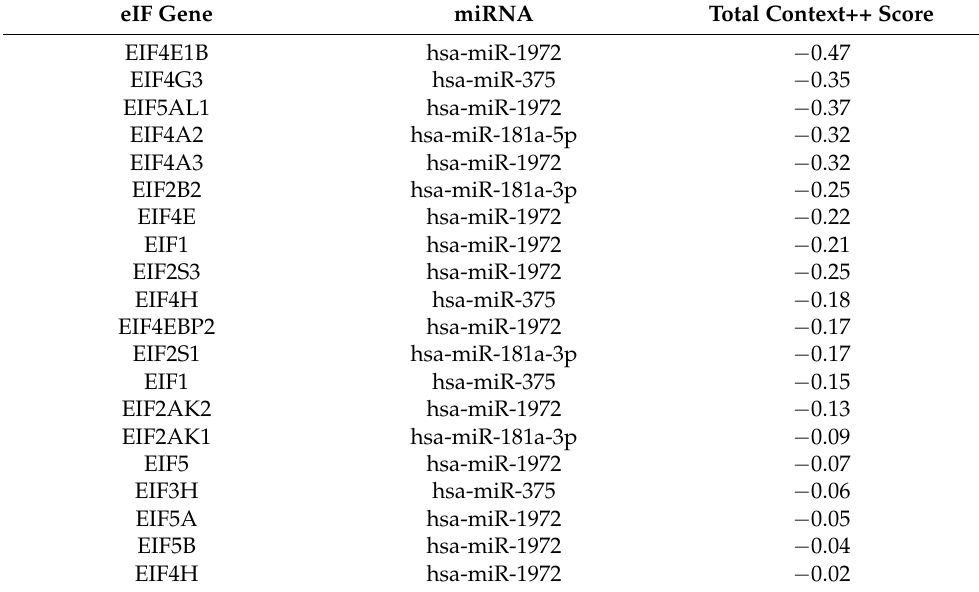
Figure 7. Correlation matrix of eIF-protein- and miRNA-abundance in the cell lines. A total of 8 cell lines and 12 eIFs, as well as 2 phosphorylation ratios and 6 miRNAs, were included in this analysis. eIF- and miRNA-abundance was expressed relative to MCF-7 and the Pearson correlation factor and significance determined. The correlation factors were then used for this cluster analysis using the CIMminer on-line tool [51]. Major clusters are numbered from 1 to 3. Significant correlations are indicated by *: p < 0.05 and **: p < 0.01. Table 6. Significant miRNA Targetscan predictions for eIFs analyzed in this study. Targets were sorted according to the context score [37].